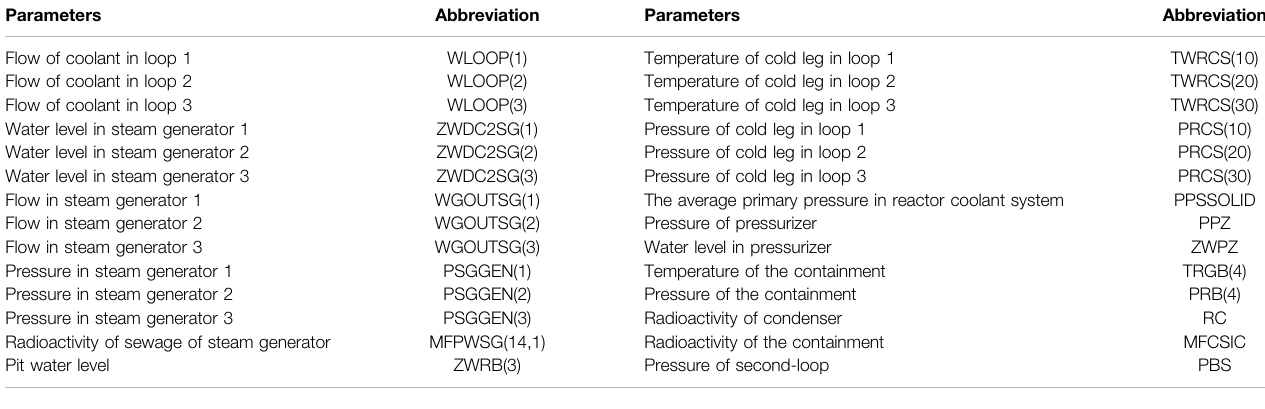
TABLE 1 | Abbreviation of parameters.